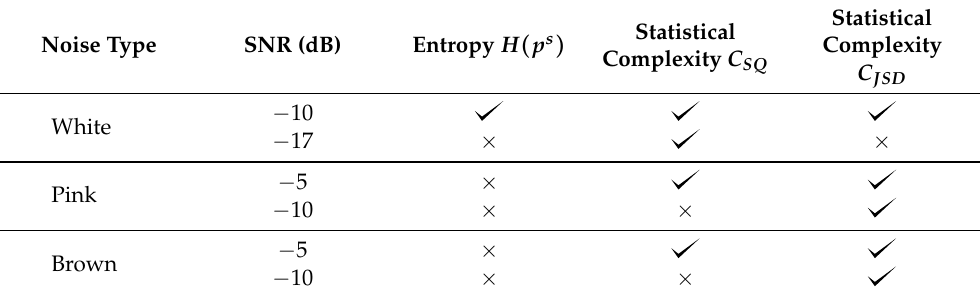
Figure 13. Statistical complexities C SQ and C JSD for brown noise model. Table 1. Comparison of information criteria for different noise models and